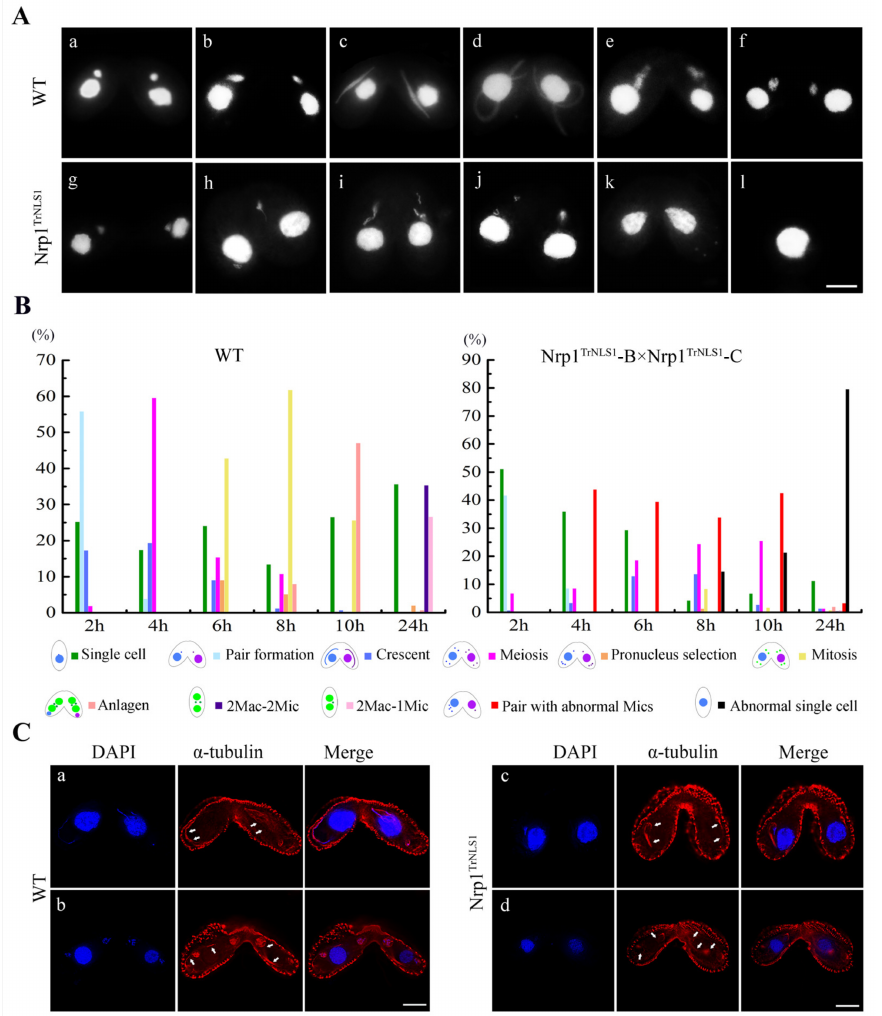
Figure 5. Micronuclear bouquet formation is affected in the Nrp1 TrNLS1 mutant. ( A ) Microscopic analysis of changes in the MIC structure during meiosis. In the Nrp1 TrNLS1 mutant, MICs failed to develop to the crescent stage. DNA was stained with DAPI; scale bar, 10 µ m. ( B ) Development of the nucleus during sexual development. Percentage of different developmental stage cells during the sexual reproduction stage in the Nrp1 TrNLS1 mutant and wild-type cell (n > 300). Cells were fixed at 2, 4, 6, 8, 10, and 24 h after mixing and staining with DAPI. ( C ) Spindle microtubule assembly was analyzed by indirect immunofluorescence localization. White arrowheads indicate spindle microtubules. The experiments were repeated thrice. ( a,b ) WT, ( c,d ) Nrp1 TrNLS1 mutant. Scale bar, 10 µ